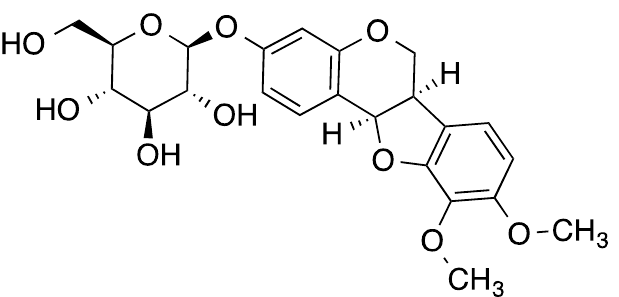
Figure 1. Structure of methylnissolin-3-O- β -D-glucopyranoside (MNG, CAS Registry Number 94367–42-7).